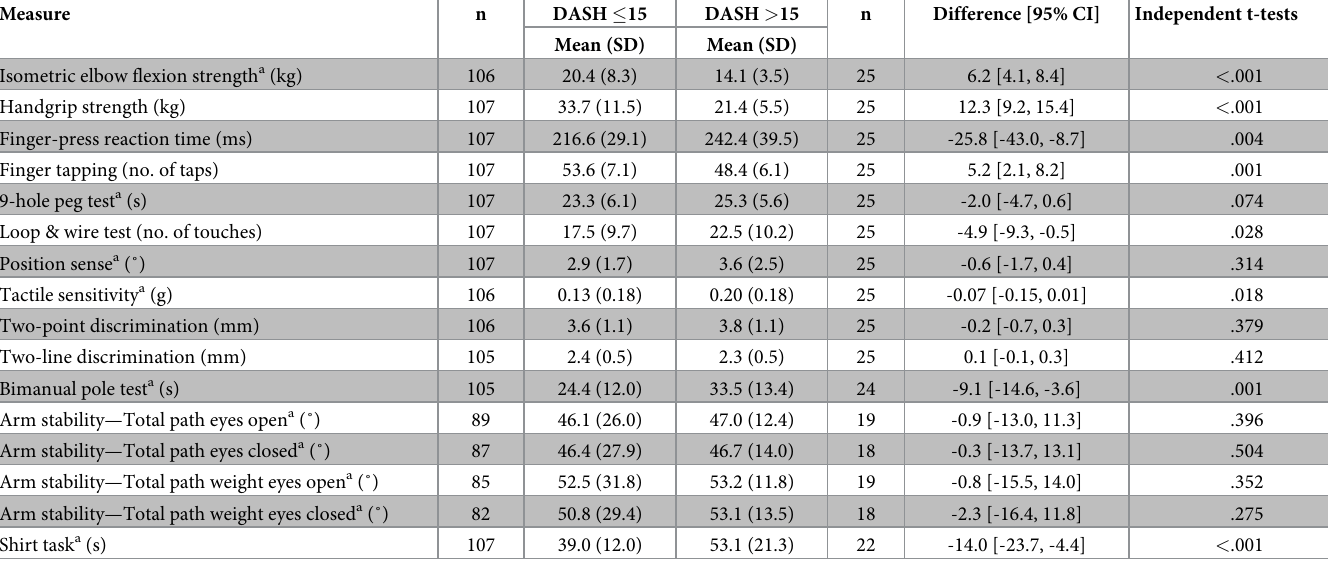
Table 7. Mean ( ± SD) scores for each DASH category (those who scored � 15 vs. those who scored > 15) for each test in those aged 60 years and over, difference in performance between DASH categories (independent